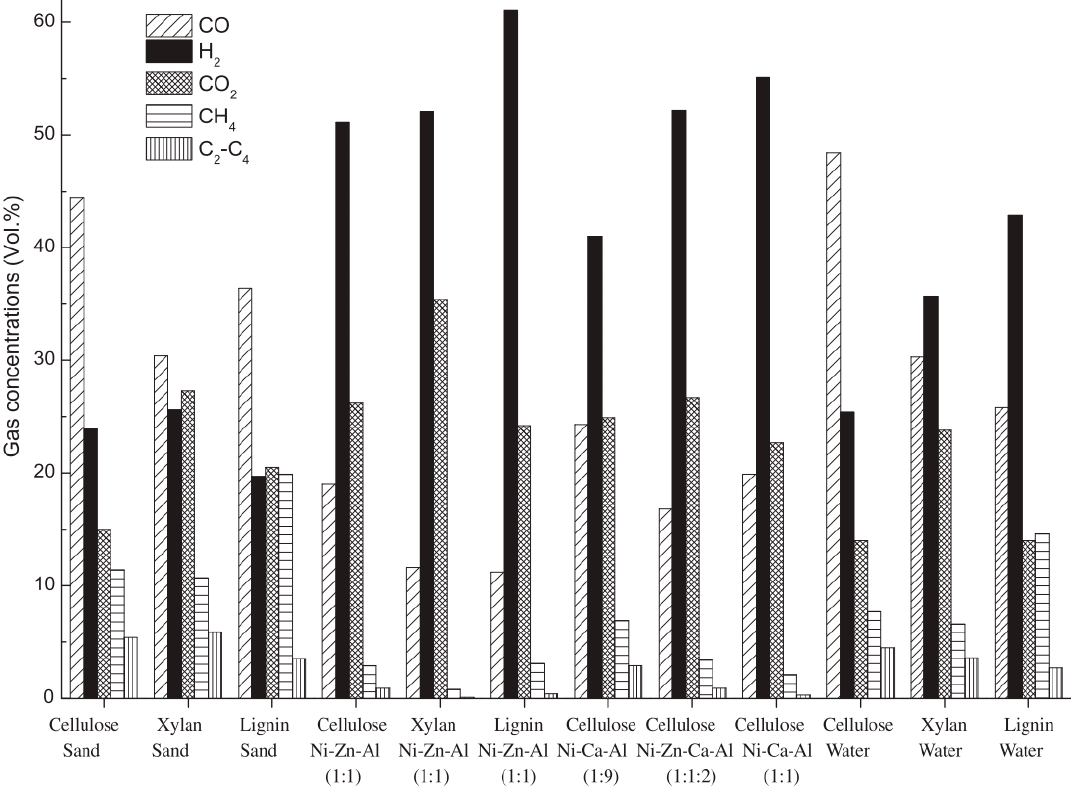
Figure 5. gas concentrations from pyrolysis/gasification of various samples [20] . Figure 5. Gas concentrations from pyrolysis